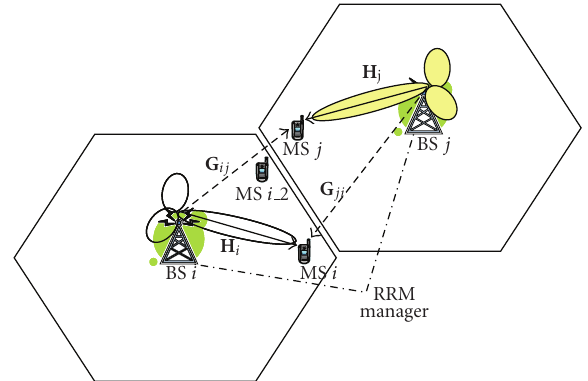
Figure 1: A simple 2 cell deployment showing BFaN.